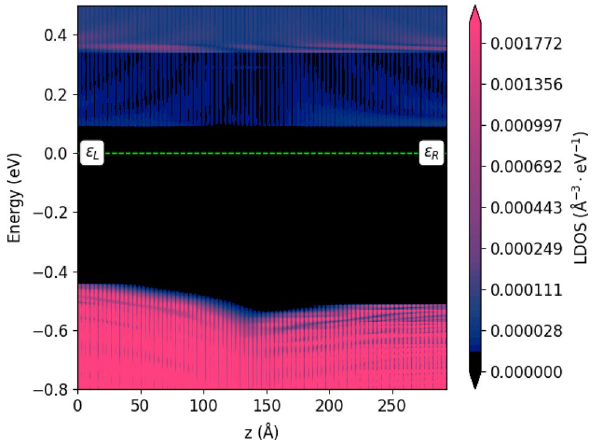
Figure 5. LDOS of InP interface between Zincblende (on the left) and Wurtzite (on the